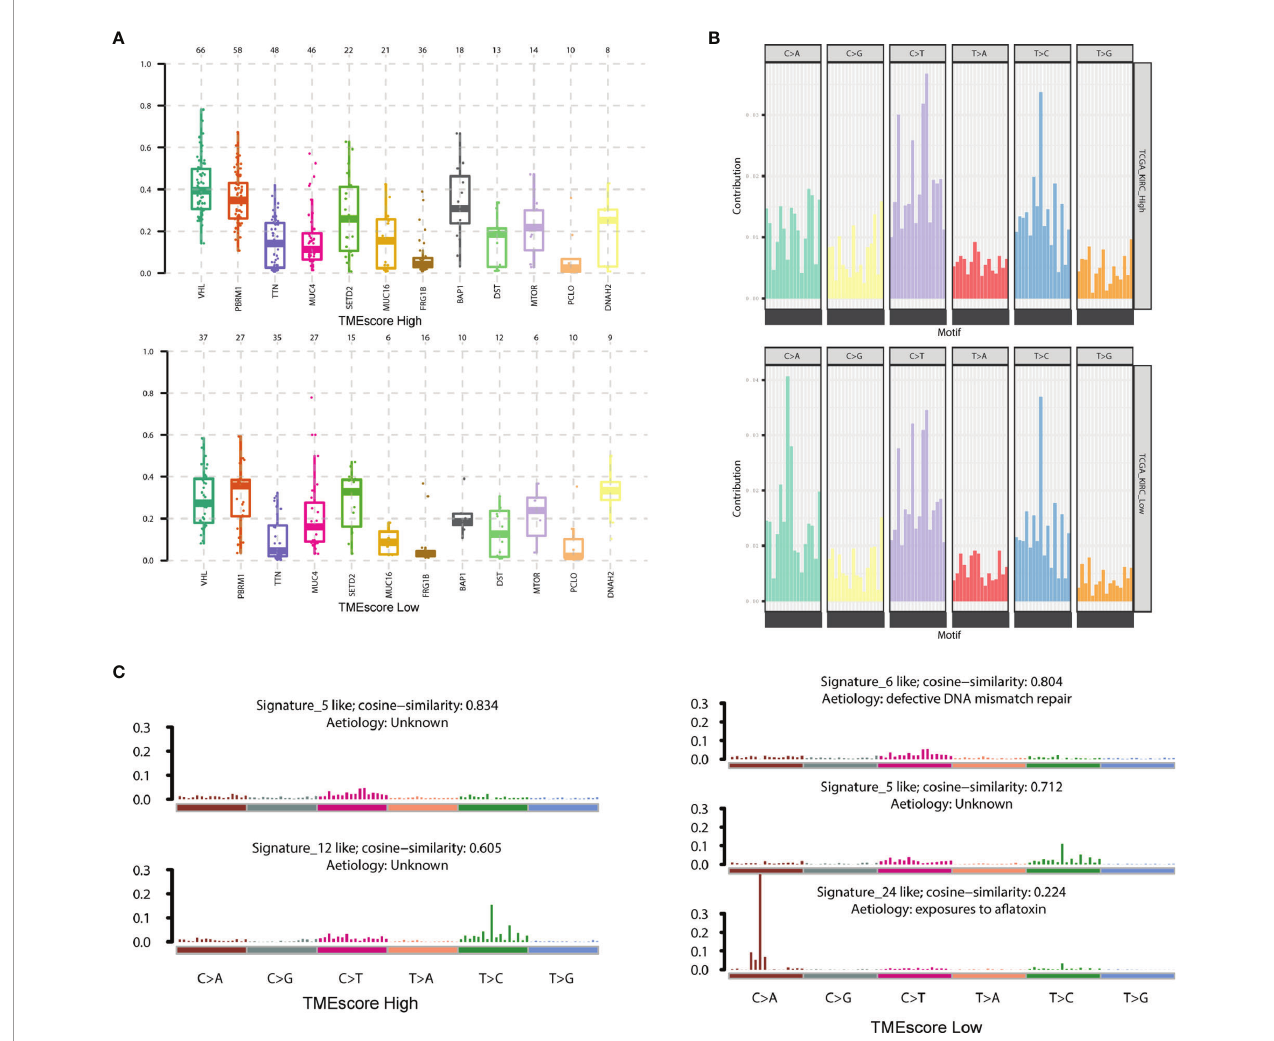
FIGURE 5 | Characterization of mutated pro fi les and related signature between two TMEscore groups. (A) The oncogenetic drivers of UBBP4, SPEN and BDP1 exhibited signi fi cantly differential mutated frequencies between two groups and we illustrated the results in boxplot. (B) We accordingly classi fi ed the mutations into 96 types and calculated the distributed frequencies in 210 KIRC samples. (C) We extracted the features and compared them with included signature in COSMIC dataset. The mutated features in TME-high group were mainly associated with signature5, signature12, while those in TME-low group correlated with signature5, signature6, signature24. The signature6 was found to be involved in DNA mismatch repair defect, and signature 24 was associated with A fl atoxin